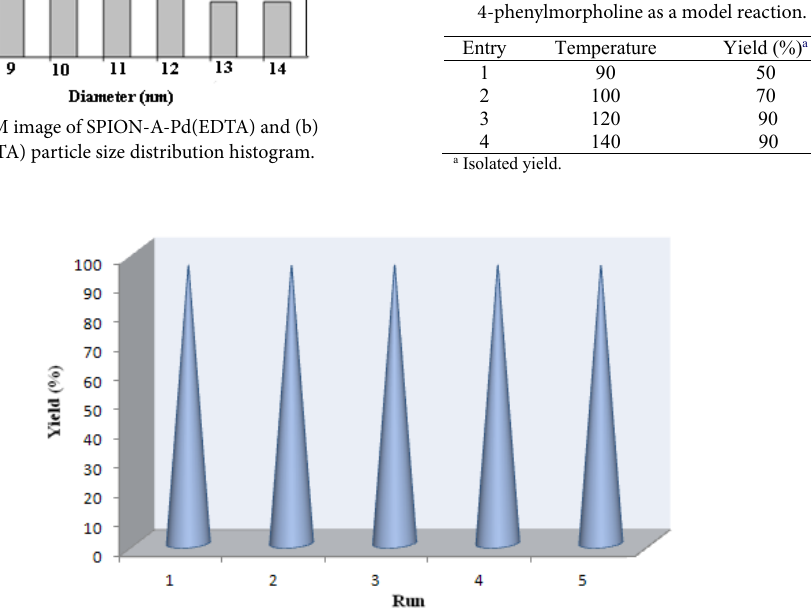
Table 4: Effect of temperature on the synthesis of